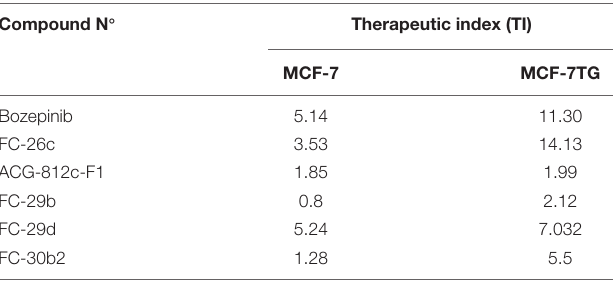
TABLE 2 | Therapeutic indexes for cyclic and acyclic O,N -acetals compounds. Compound N ◦ Therapeutic index